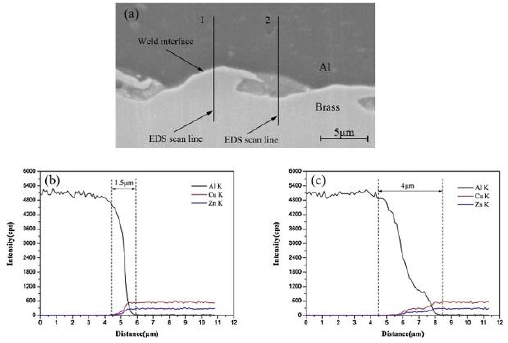
Figure 13. EDS (Energy Dispersive Spectrometer) curves of impact weld melting block (reproduced from [27], with permission of Elsevier 2019) ( a ) SEM image of aluminum/copper weld interface with fusion block; ( b , c ) EDS curves at positions 1 and 2.